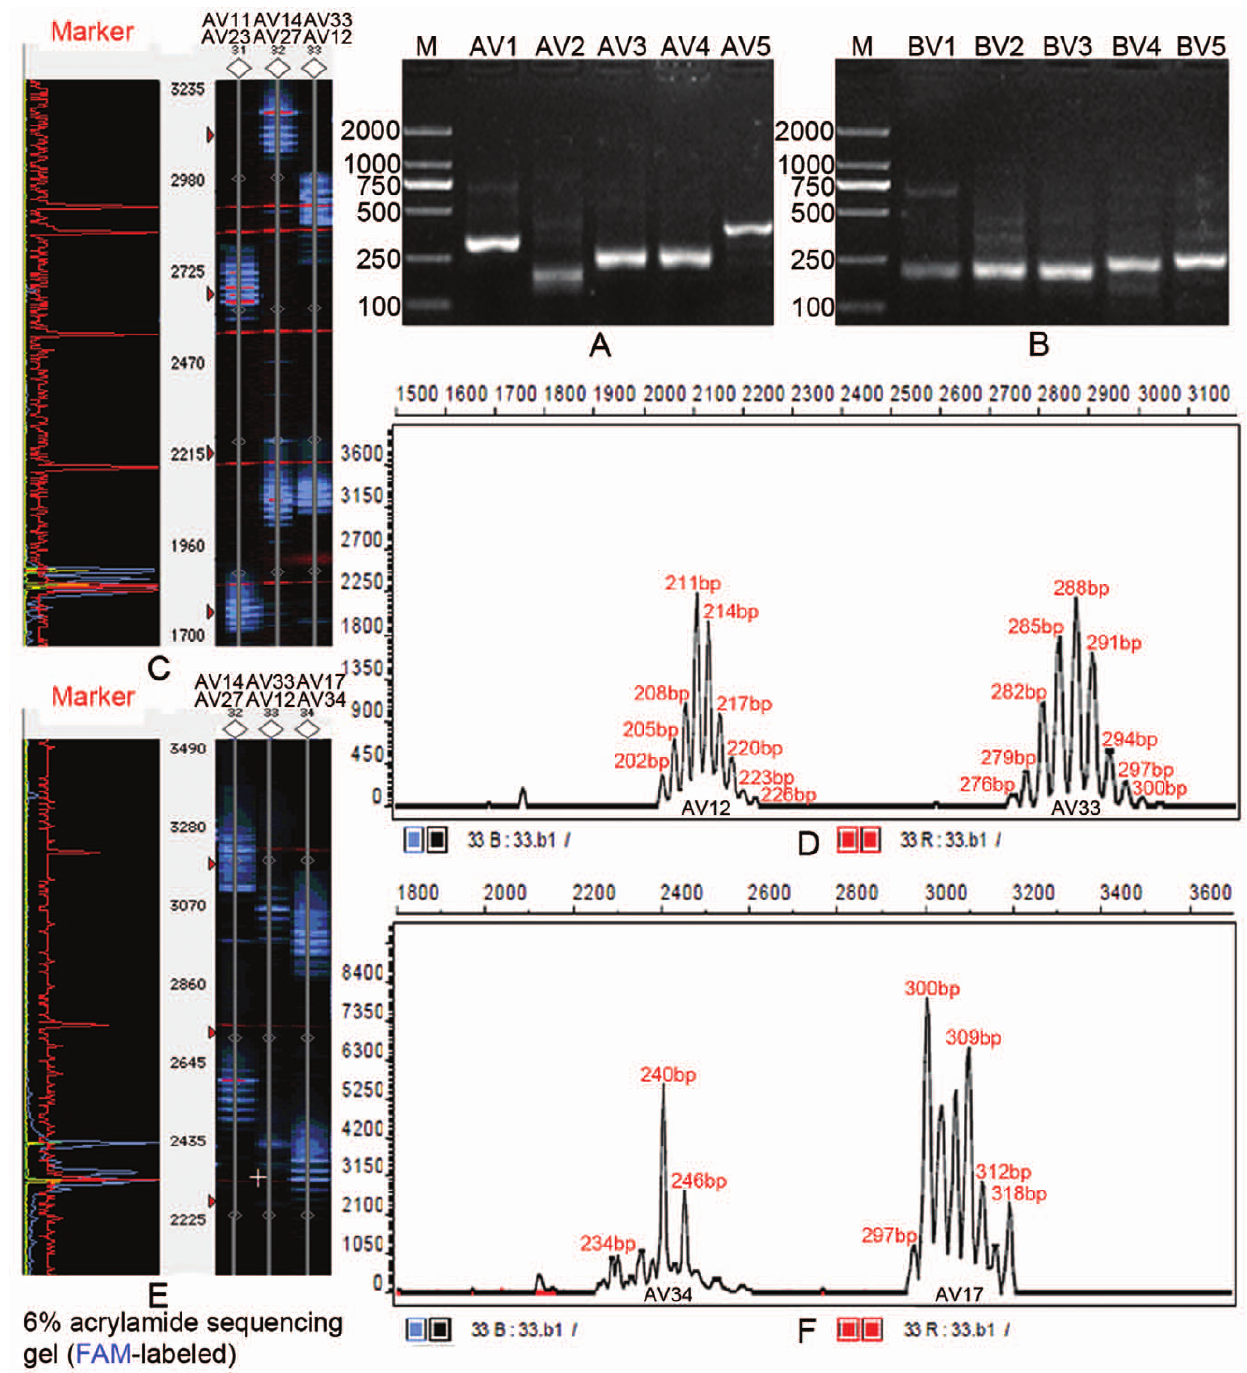
Figure 1. GeneScan results of partial TCR V a and V b CDR3 products of CD4 + T cell. (A) PCR products of TCR V a 1-V a 5 of TB patient-1 (mild group) analyzed on a 1.5% agarose gel stained with ethidium bromide. (B) PCR products of TCR V b 1–V b 5 of TB patient-1 analyzed on 1.5% agarose gels. (C) Partially fluorescent PCR products of TCR V a of healthy control-1 analyzed on a 6% acrylamide sequencing gel. (D) CDR3 size and fluorescence intensity analysis of V a 2 and V a 33 of healthy control-1. (E) Partially fluorescent PCR products of TCR V a of TB patient-1 analyzed on a 6% acrylamide sequencing gel. (F) CDR3 size and fluorescent intensity analysis of V a 17 and V a 34 of TB patient-1.